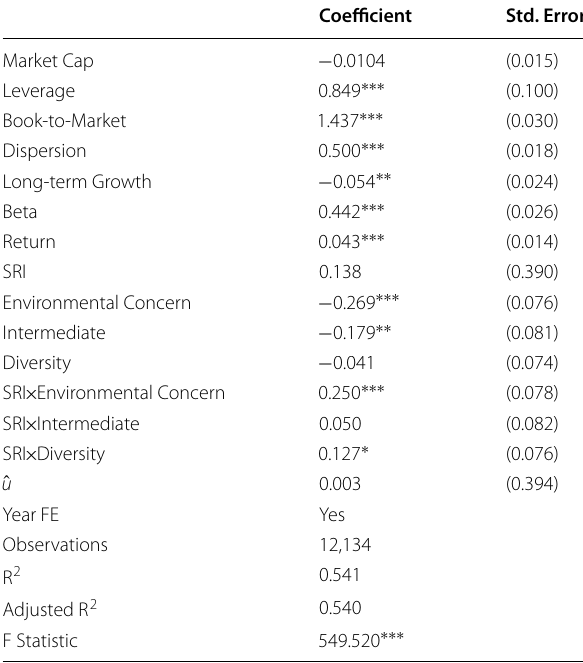
Table 4 Influencing factors of heterogeneous effect of SRI